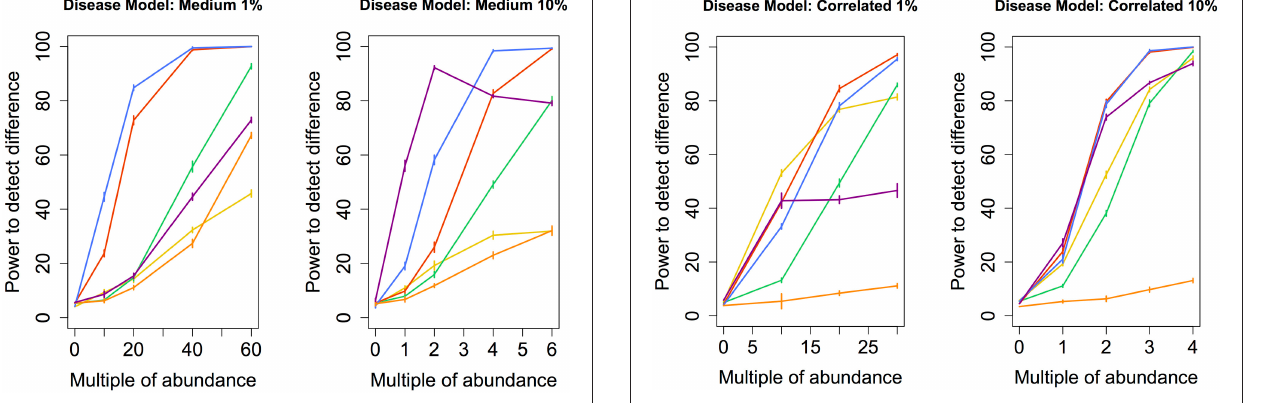
FIGURE 5 | Correlated disease model: power comparison of the best performing statistical techniques from each category. Bars represent standard errors of the mean. [Purple: modified metastats; Blue: Partial least squares regression (all components); Red: principal components regression (all components); Orange: diversity; Green: distance-based regression (Manhattan distance); Yellow: regularized regression